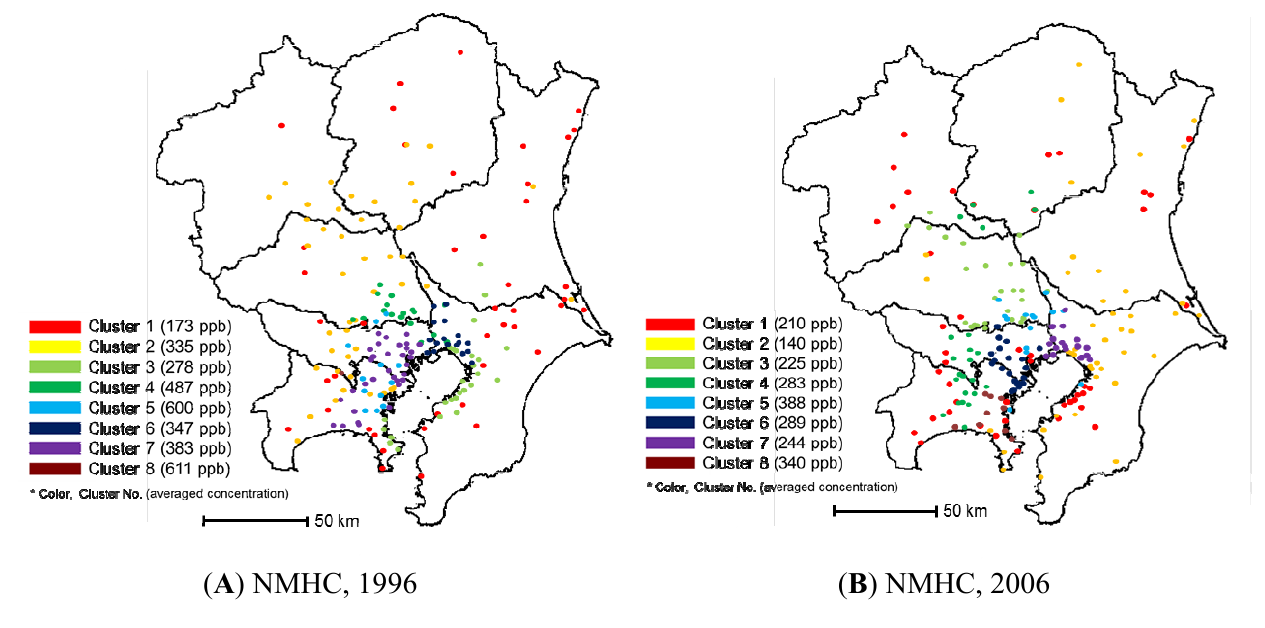
Figure 7. Results of clustering using NMHC monitoring data: ( A ) in 1996 and ( B ) in